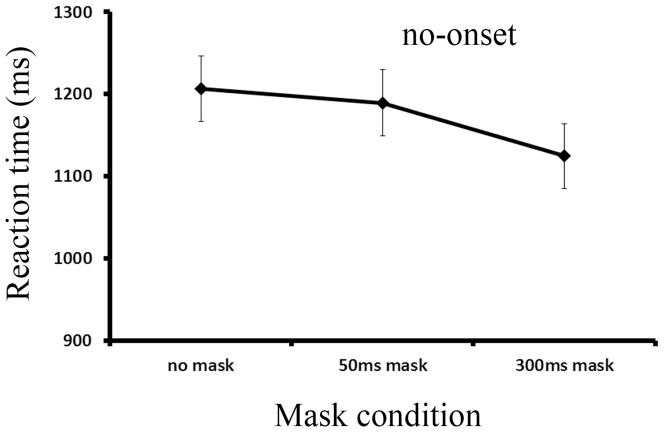
The mean reaction time of all conditions in Experiment 2.